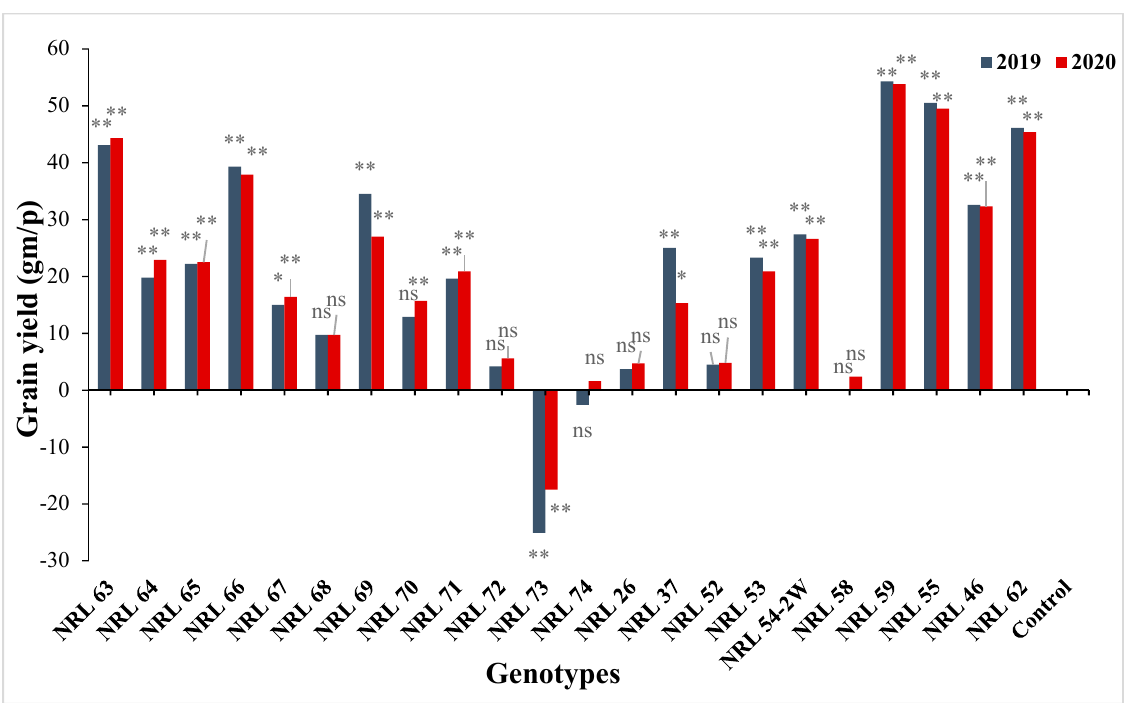
Figure 9. The percentage of advantage over commercial variety for 1000-grain weight of studied genotypes during the 2019 and 2020 growing seasons. Means **: Highly significant at 1%; *: Significant at 5%; ns: Non-significant.